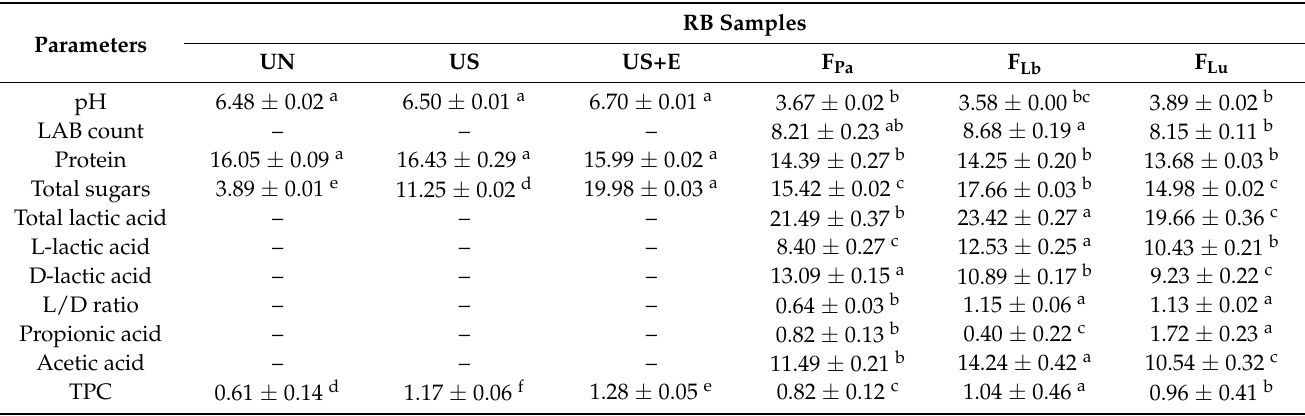
Table 1. pH values, lactic acid bacteria (LAB) count (log 10 CFU/g) contents of protein, sugars, and organic acids (g/100 g dw), and total phenolic compounds (TPC) (mg GAE/g dw) in untreated and functionalized rice bran